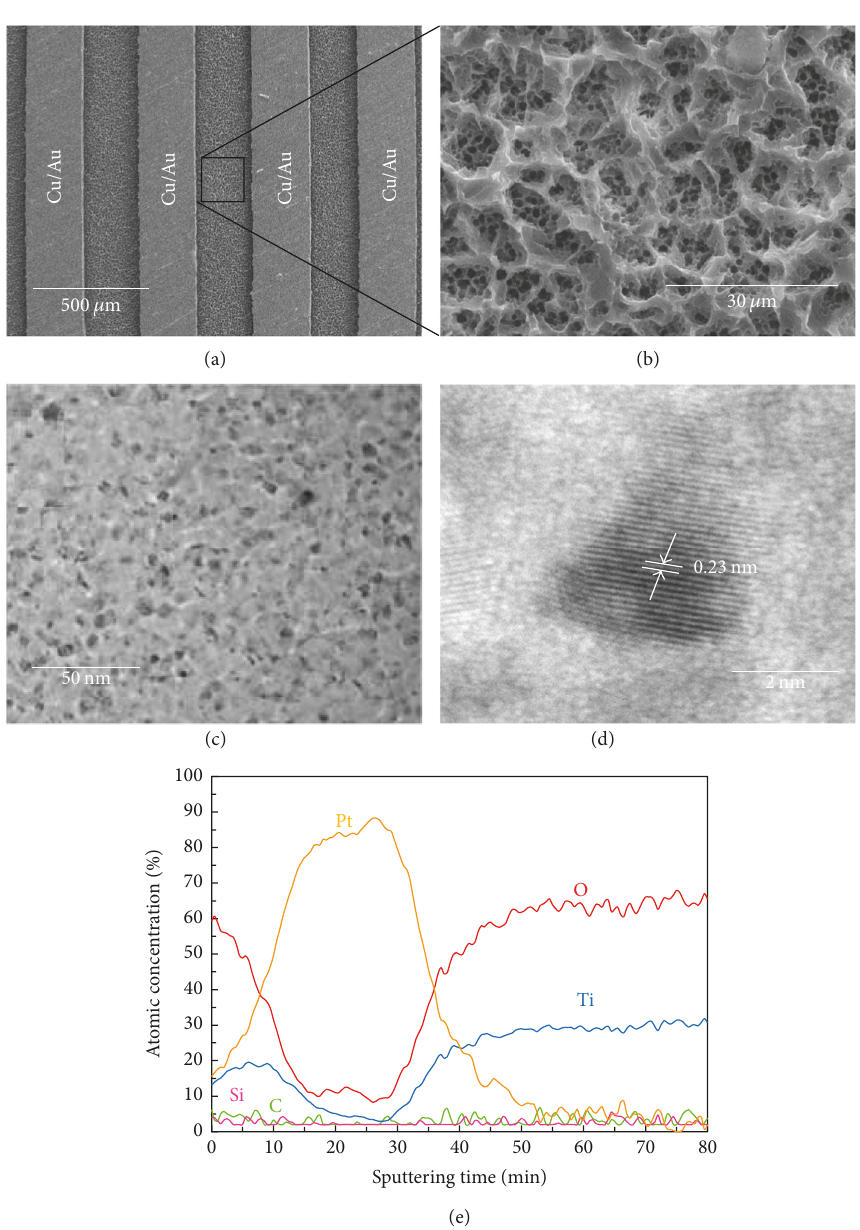
Figure 3: SEM images of PCB substrate at (a) low and (b) high magnifications, TEM images of the TiO 2 /Pt/TiO 2 layers at (c) low and (d) high magnifications, and (e) Auger depth profile of the TiO 2 /Pt/TiO 2 layers on the SiO 2 /Si substrate.